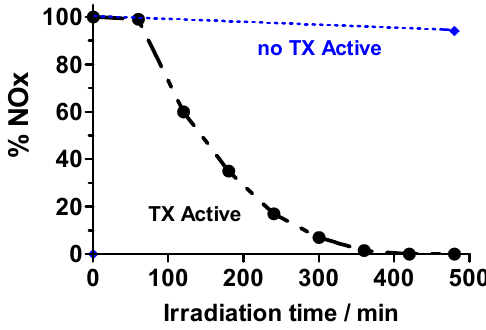
Figure 33. Plots illustrating the immediate destruction of NO x upon turning the light on and after 60 min of lamp stabilization of the chamber (recirculation tests). Plot made from data reported in Borgarello [121].